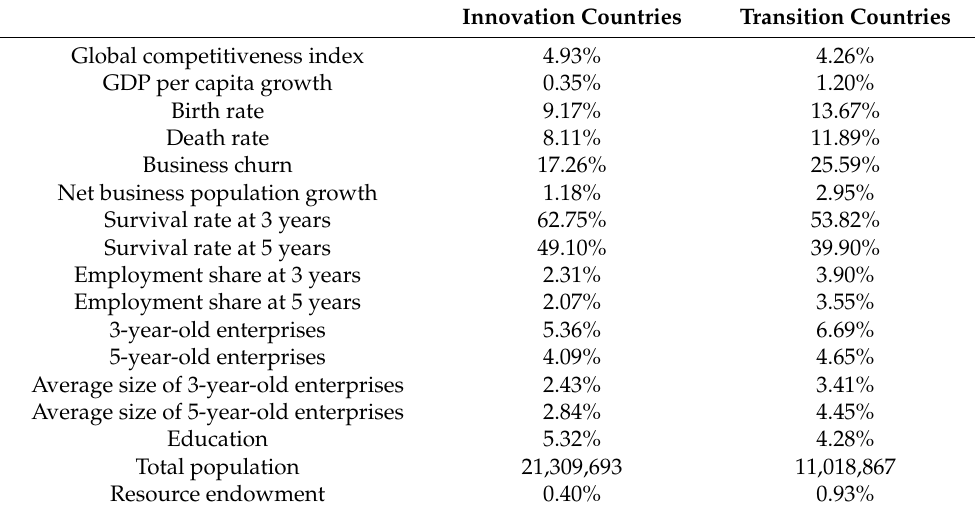
Table 3. Comparing average values of indicators for transition and innovation